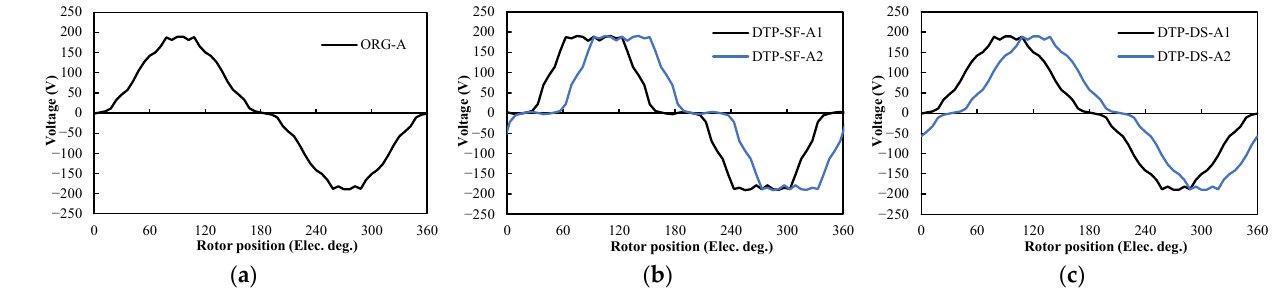
Figure 14. Phase back EMF of different winding configurations at 3000× g rpm: ( a ) ORG; ( b ) DTP-SF; ( c ) DTP-DS.